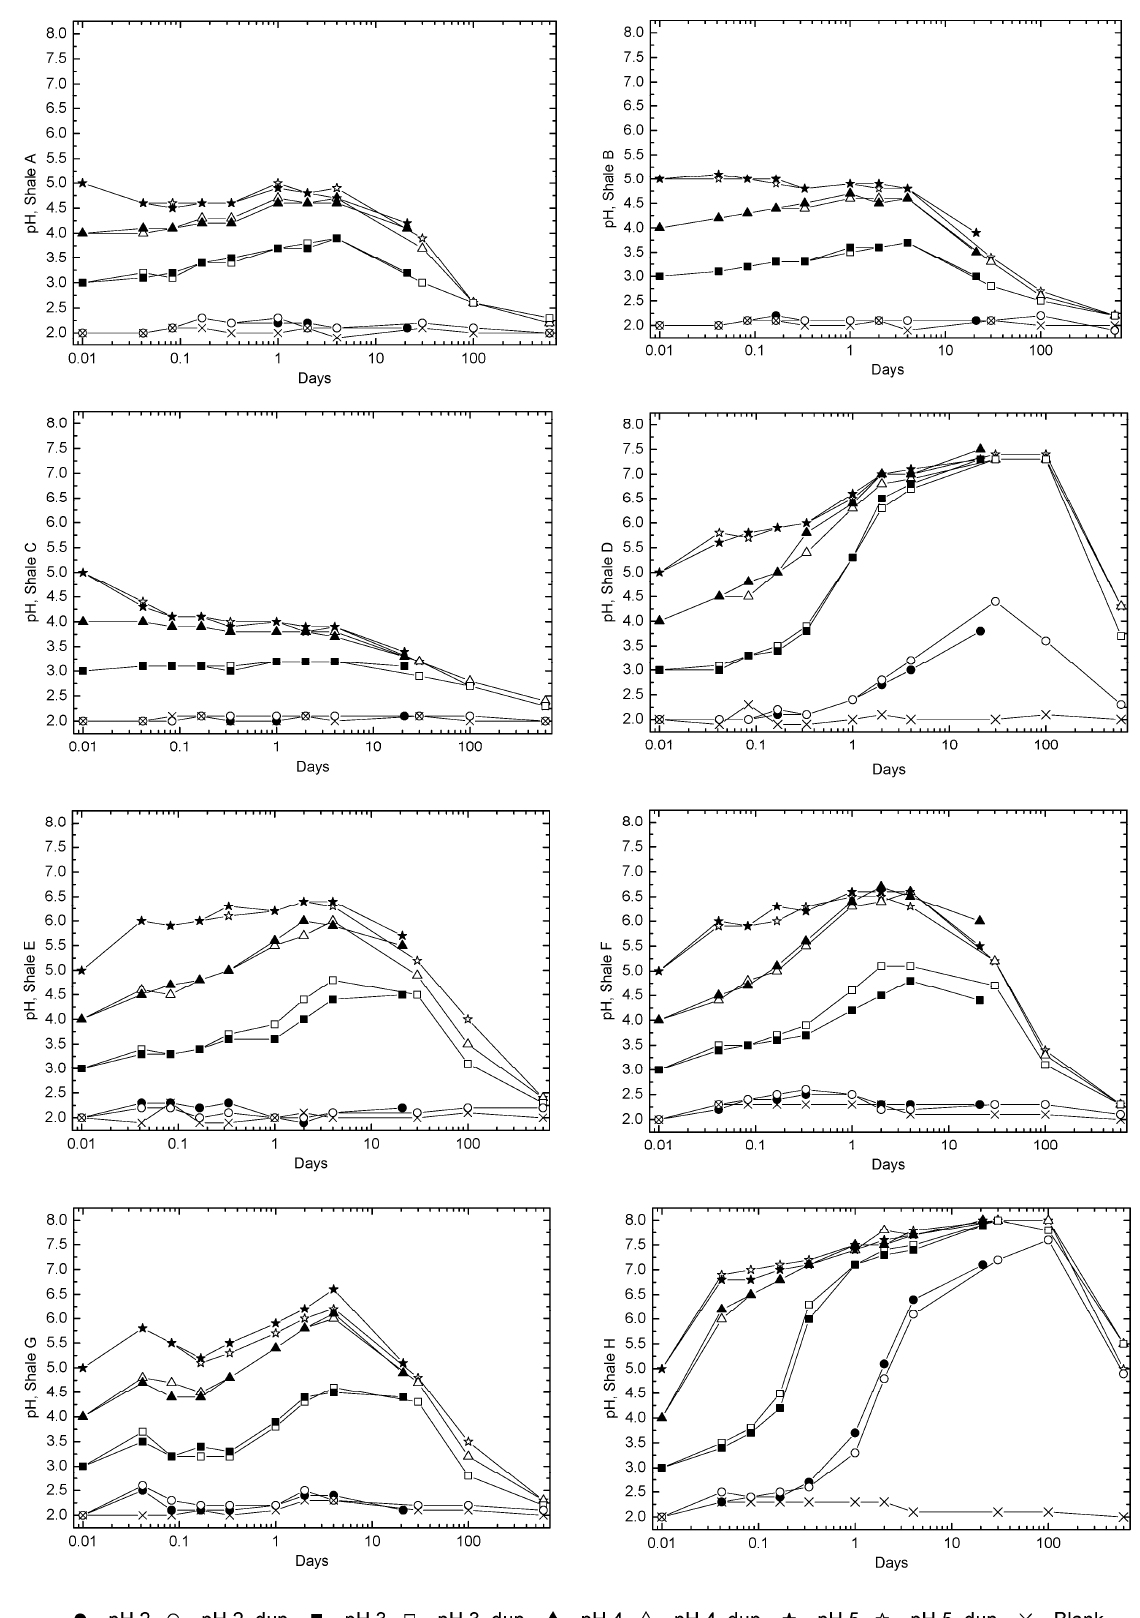
Figure 1. Solution pH recorded over time for all reaction vessels for all samples. Points on lines mark sample intervals from experiment commencement and 1, 2, 3, and 8 h, and 1, 2, 4, 21, 30, 100 and 600 days (logarithmic scale). The legend indicates initial sample